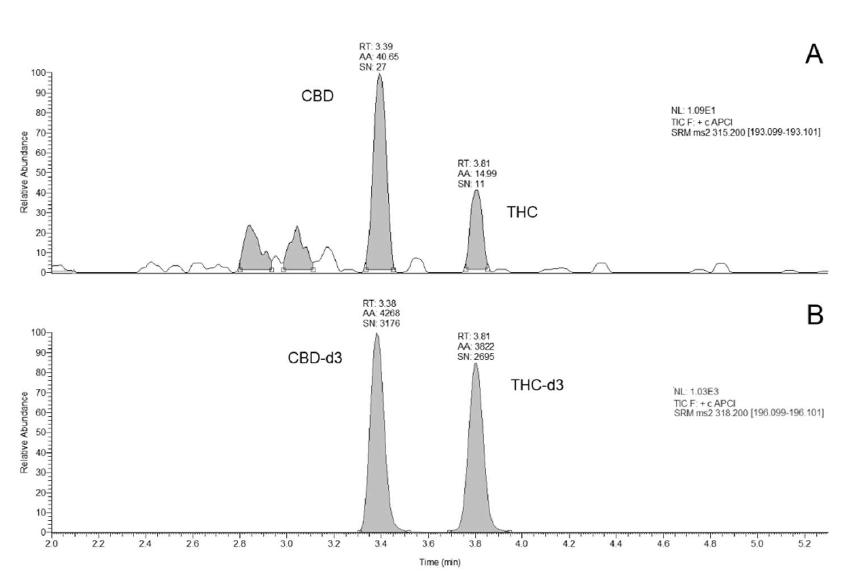
Figure 1. Chromatograms obtained: a calibrator at the LLOQ (panel A ); deuterated internal standards (panel B ). RT, retention time. AA, automatic area, SN, signal to noise ratio. NL, normalized level. Table 1. Results of Intra-day and inter-day accuracy and reproducibility assays. The quality controls